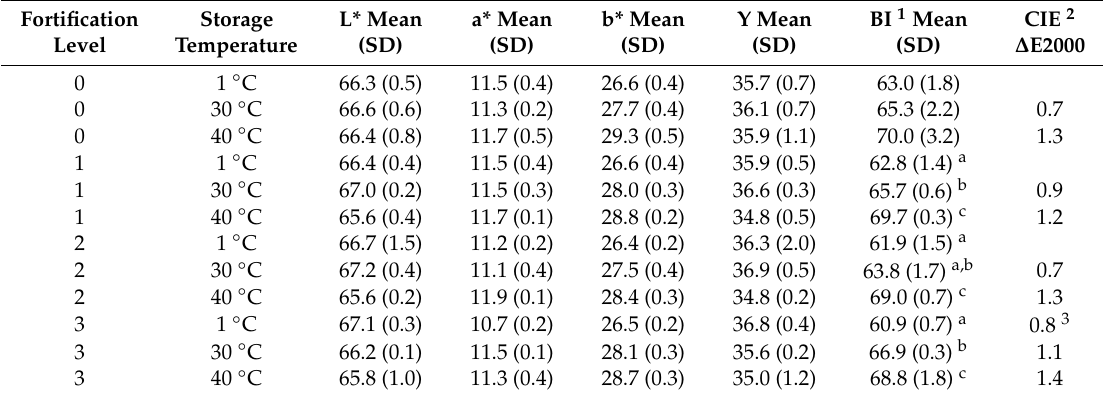
Table 3. Colour results after 24 months of